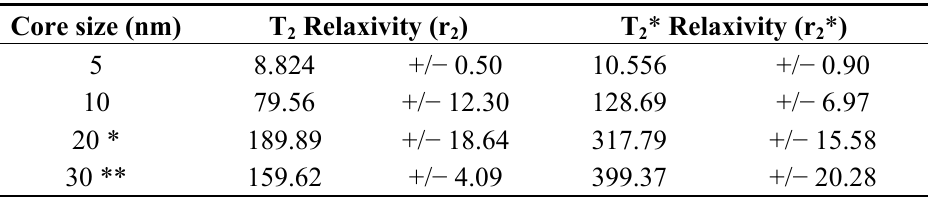
and r * for each core size expressed as mM − 1 s − 1 ( n = 5 data 2 2